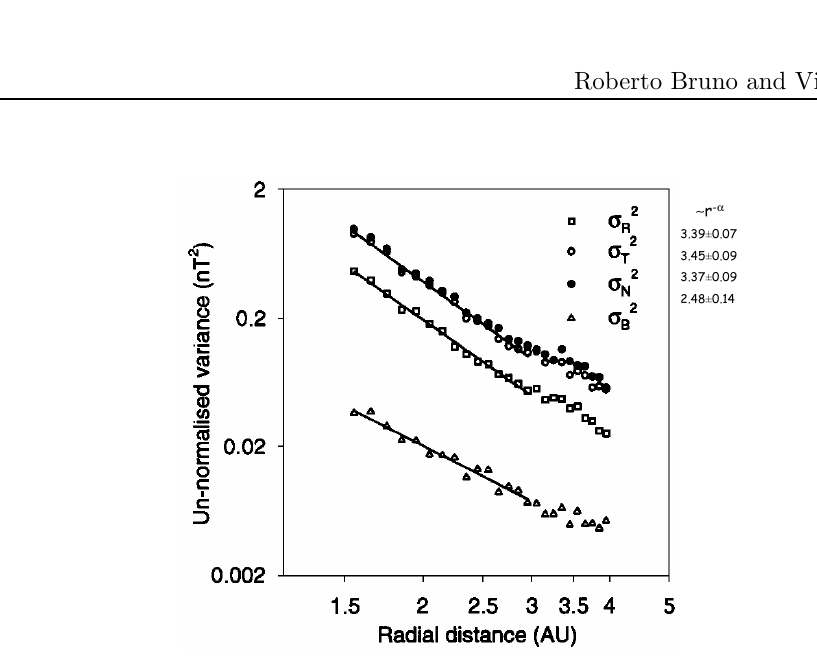
Figure 57: Hourly variances of the components and the magnitude of the magnetic field vs. radial distance from the Sun. The meaning of the different symbols is also indicated in the upper right corner. Image reproduced by permission from Forsyth et al. (1996), copyright by